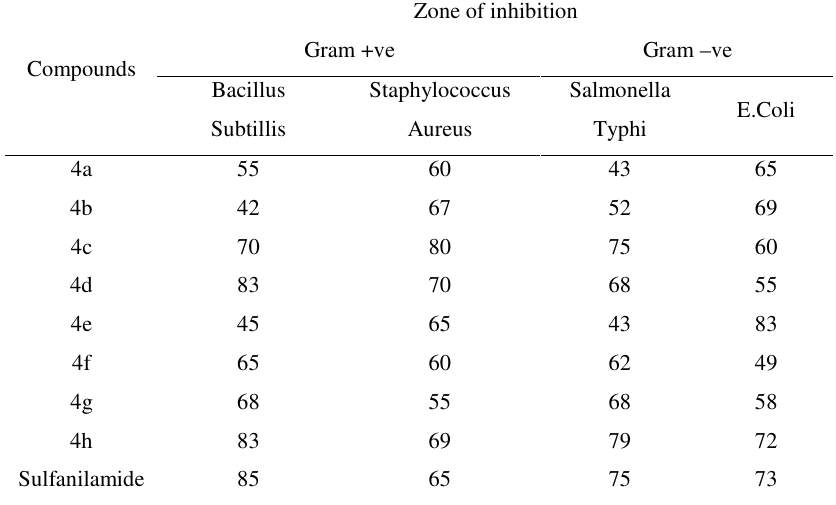
Table 3. Antibacterial Activity of compounds